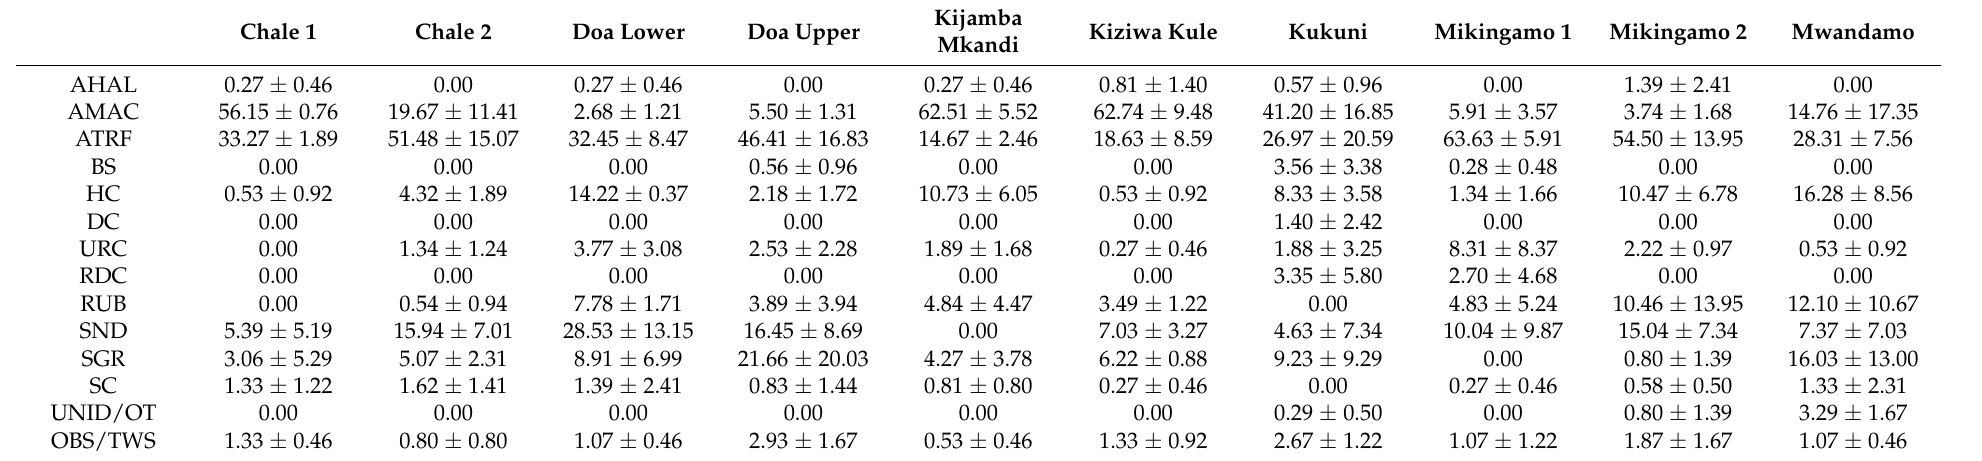
Table 3. Percentage cover of the benthos per site ± standard